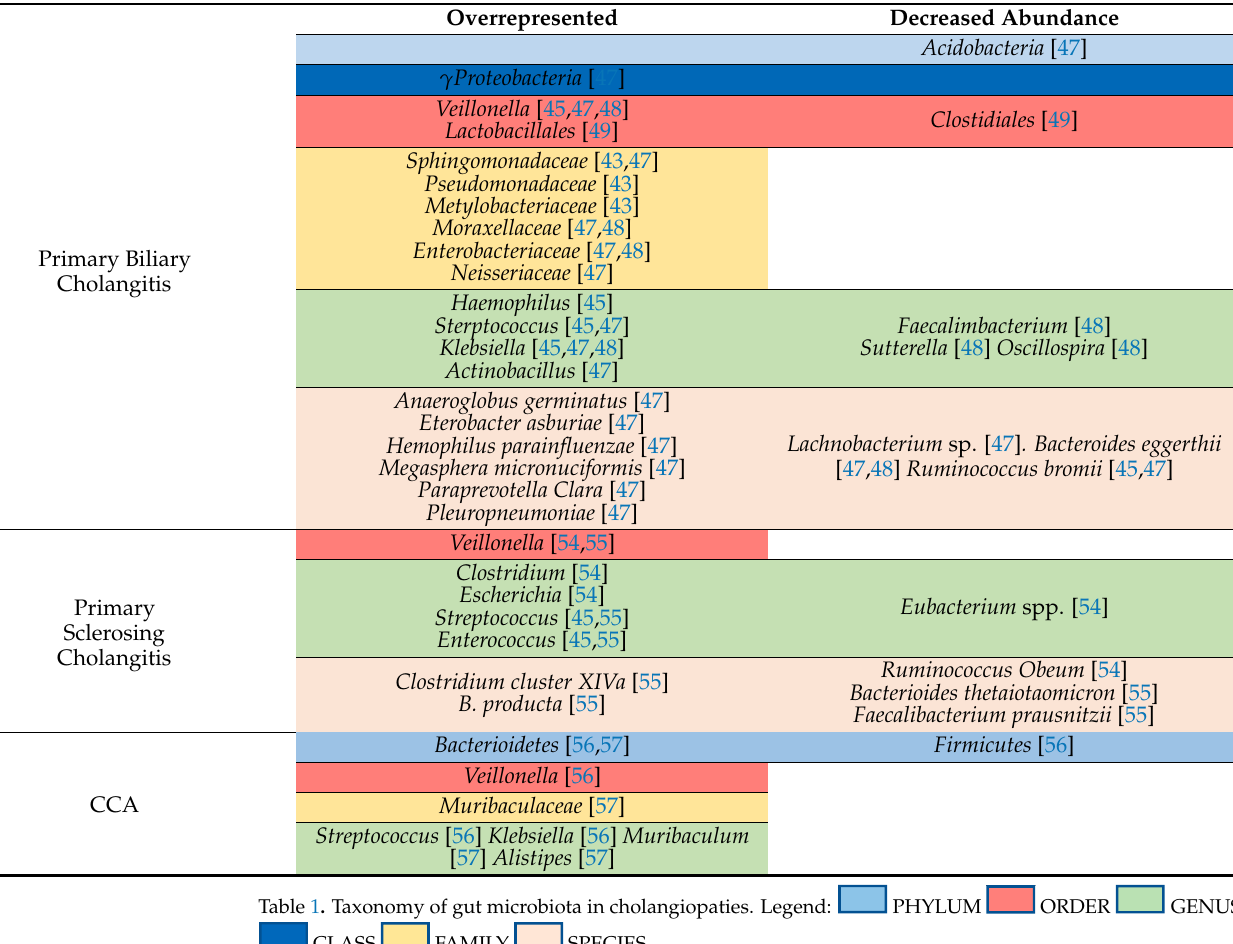
GENUS Table 2. Changes in biliary microbiota in cholestatic liver diseases.